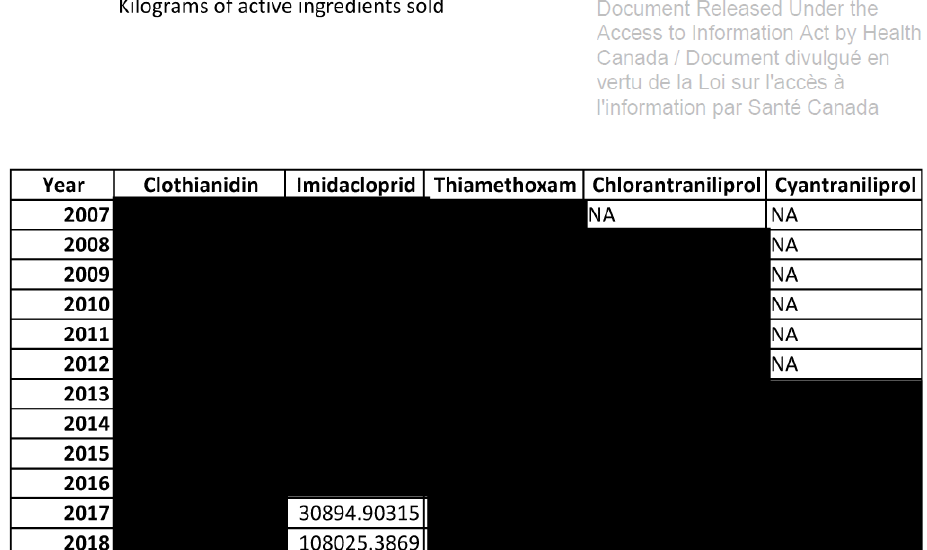
Figure 1. Canadian sales data of five neonicotinoids received from Health Canada following a request made under the Access to Information Act. The blackout data is censored, and NA means Not Available.